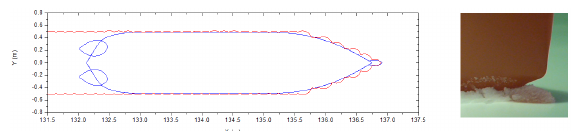
Figure 6: Icebreaking pattern around the bulbous bow in 22 mm (0 . 53 m full-scale) level ice.